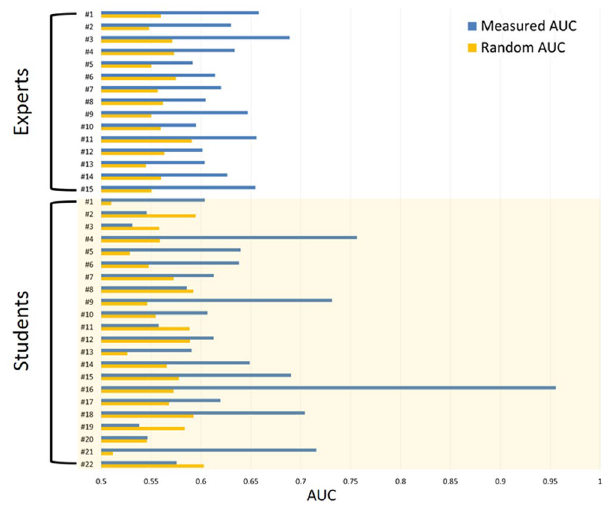
Figure 7. Bars plot of the averaged Measured AUC (blue bars) across all the possible labels combinations with respect to the Random AUC (orange bars) for each ATCO. In particular, the AUC values of the Experts are reported on the top part of the image, while those of the Students are reported on the